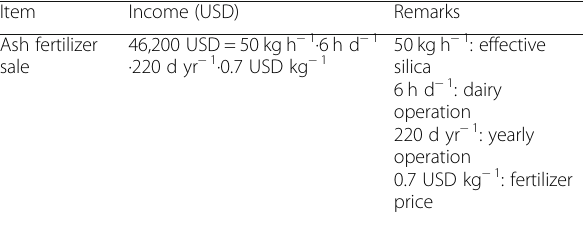
Table 6 Revenue from the sale of silica